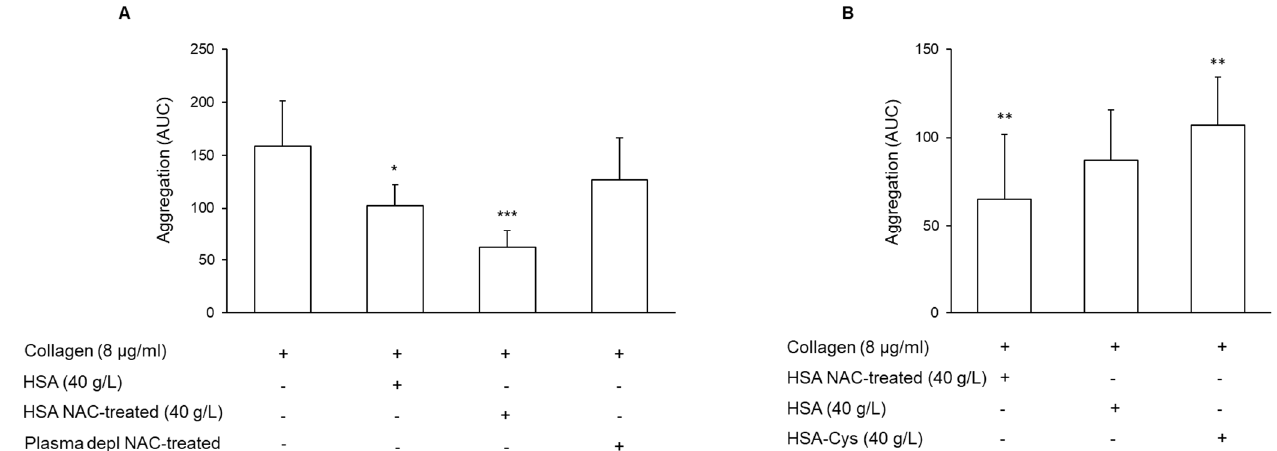
Figure 3 . Effect of the different redox status of HSA on platelet aggregation. ( A ) Plasma depleted of high molecular weight proteins including HSA was incubated with or without HSA pre-treated with vehicle or NAC for 30 min at 37 °C. Platelet aggregation was induced by the addition of collagen and monitored for 6 min, n = 6. * p < 0.05, *** p < 0.001 vs. collagen-stimulated platelet. ( B ) HSA pre-treated with vehicle or NAC for 30 min at 37 °C or HSA-Cys was added to plasma depleted. Platelet aggregation was induced by the addition of collagen and monitored for 6 min, n = 5. ** p < 0.01 vs. platelets resuspended with plasma depleted containing HSA, for ANOVA and Dunnett’s post hoc test.